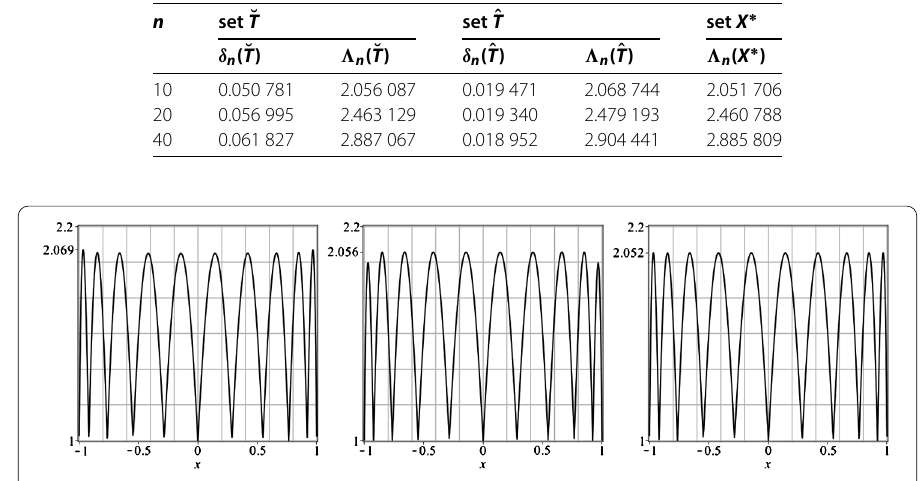
ˆ T ) and (cid:6) n (